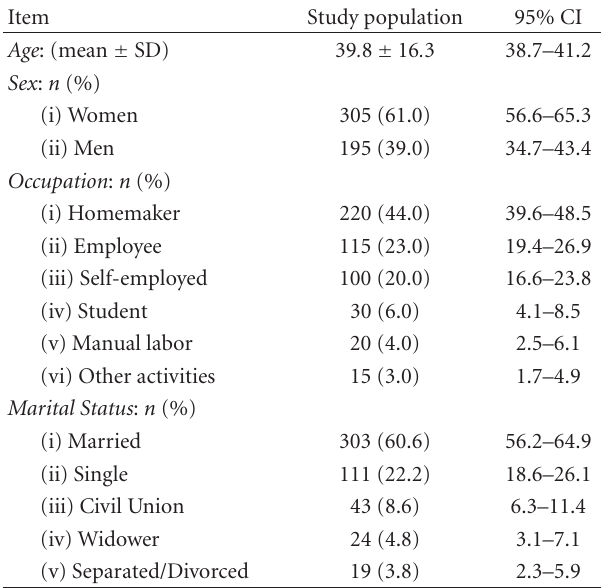
Table 1: Demographic characteristics of the study